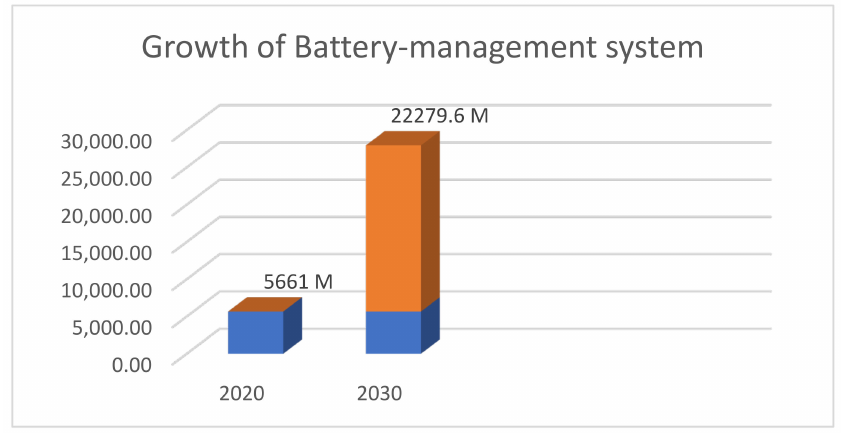
Figure 1. Growth of Battery-management systems from 2020 to 2030